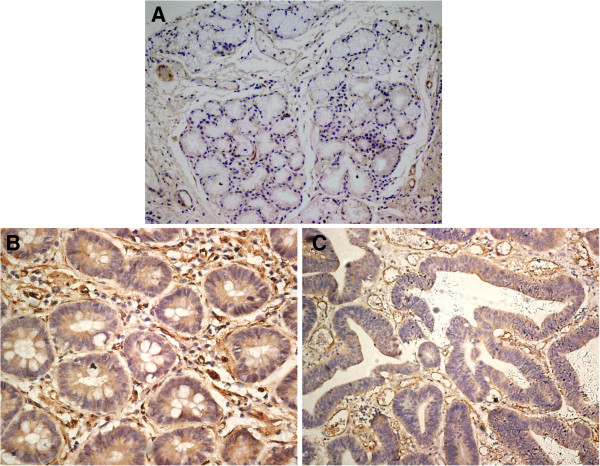
Human gastric cancers and healthy mucosa specimens in tissue microarray were stained with an anti-SLC38A1. (A) Representative healthy gastric tissue without SLC38A1 cytoplasmic expression, (B) Well-differentiated and (C) Morderately-differentiated gastric cancer tissues with positive SLC38A1 expression which was cytoplasm stained brown and diffuse. Magnification × 200.